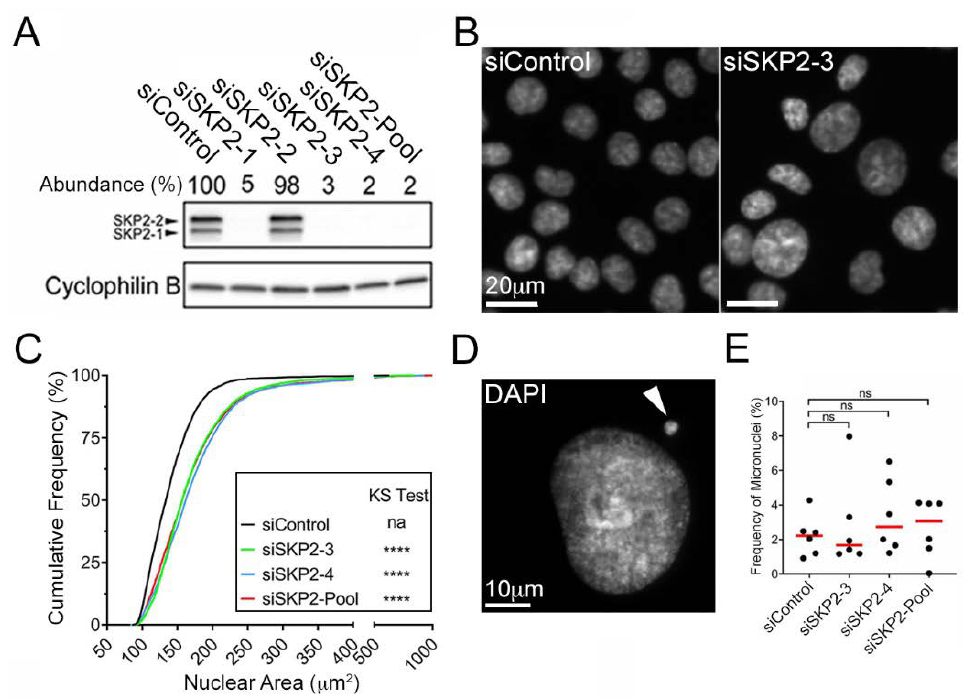
Figure 3. SKP2 Silencing Corresponds with Significant Increases in Nuclear Areas in HCT116. ( A ) Western blots presenting SKP2 abundance following siRNA-based silencing with individual (siSKP2-1, -2, -3, -4; top labels) and pooled (siSKP2-Pool) siRNAs relative to siControl; Cyclophilin B serves as the loading control. Note that two bands representing the two SKP2 isoforms (SKP2-1 and SKP2-2; left labels) are visible [64,65]. Semi-quantitative analyses were performed whereby SKP2 abundance was first normalized to the respective loading control and is presented relative to siControl (100%). ( B ) Low-resolution images of Hoechst-counterstained nuclei showing visual increases in nuclear areas following SKP2 silencing relative to siControl. ( C ) Cumulative distribution frequency graph reveals significant increases (rightward shift) in nuclear areas following SKP2 silencing relative to siControl (two-sample KS test; na, not applicable; ****, p -value < 0.0001; N = 3, n = 6). ( D ) High-resolution image presenting a Hoechst-counterstained nucleus and associated micronucleus (arrowhead). ( E ) Dot plot and subsequent statistical analyses (MW test; ns, not significant, p -value > 0.05) fail to identify significant changes in micronucleus formation following SKP2 silencing (red bars identify median values; N = 3, n = 6).